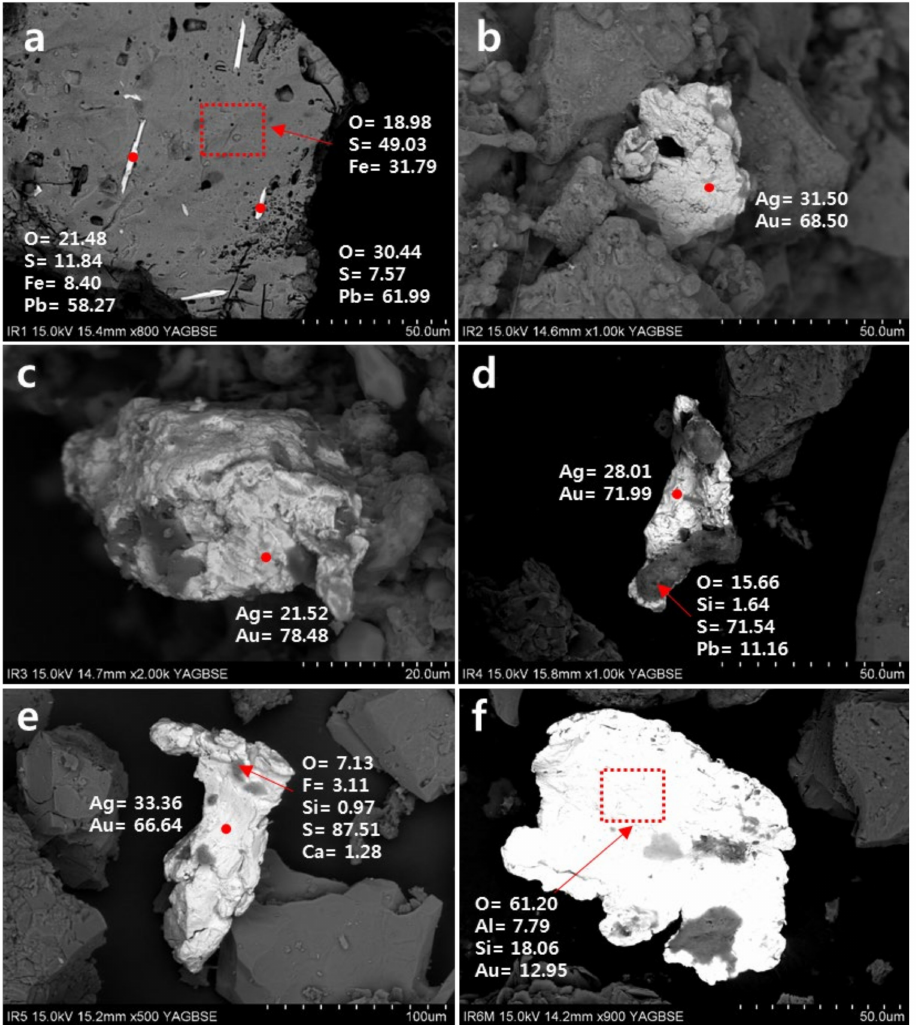
Figure 8. SEM-BSE image and SEM-EDS of native gold grains, sulfide minerals and gangue minerals on the insoluble residue (( a – f ); nitric acid 1.0–6.0 M, respectively). Red dots and arrows are EDS spot